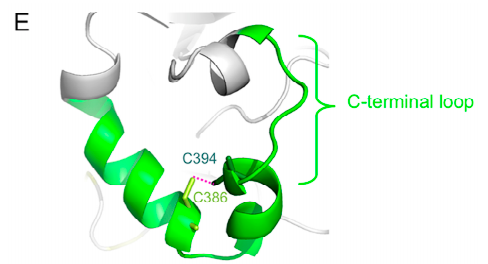
Figure 1. Top view of MV-H and the locations of HNE, NE, and LE. ( A ) Ribbon diagram. MV-H has a six-bladed β -propeller fold ( β 1– β 6). β -Sheets 1, 2, 3, 4, 5, and 6 are shown in blue, red, orange, yellow, light green, and green, respectively; ( B ) Schematic diagram. Light green, blue, and green ovals indicate locations of HNE, NE, and LE, respectively. Black solid and dashed lines indicate the overall structure of the H protein; ( C , D ) Locations of HNE, NE, and LE. The amino acids demonstrated or suggested to constitute a portion of an epitope are shown in colors: residues on β -sheets 1, 2, 3, 4, 5, and 6 are shown in blue, red, orange, yellow, light green, and green, respectively. Light green, blue, and green dashed-line circles indicate locations of HNE, NE, and LE, respectively. ( C ) Cartoon model. ( D ) Surface presentation and MAbs that recognize HNE, NE, and LE. ( E ) Enlarged view of HNE. Stick models indicate two cysteine residues, and the dashed red line indicates the disulfide bond between the cysteines.